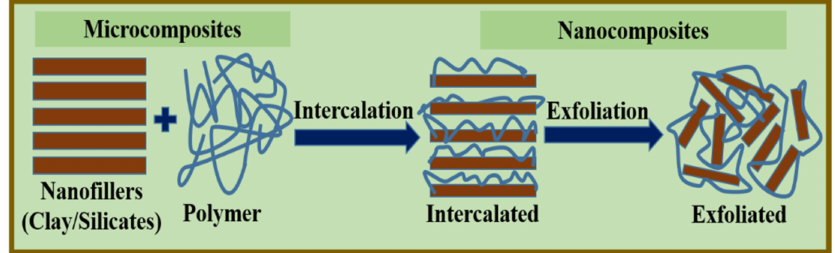
Figure 3. Schematic illustration of a nanofiller/polymer nanocomposite.